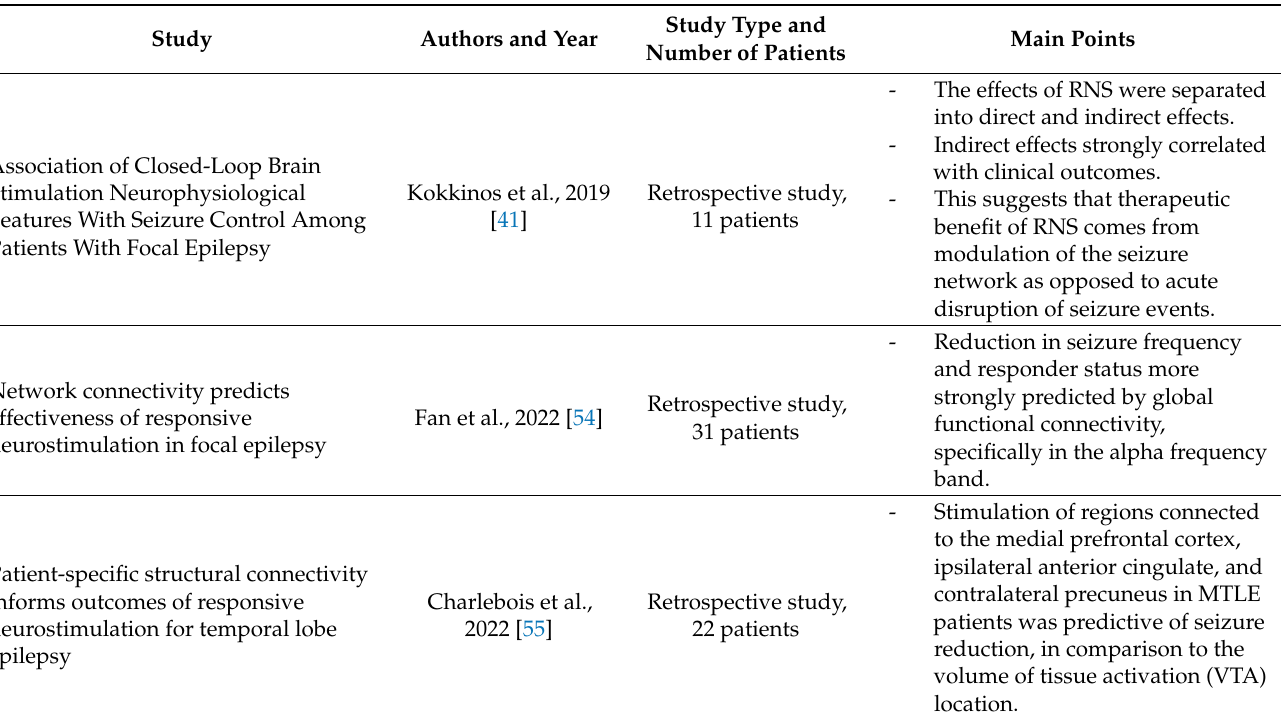
Table 2. Studies suggesting that RNS works by seizure network disruption. Summary of the major recent studies that establish that the therapeutic mechanism behind RNS is likely epileptic network disruption and